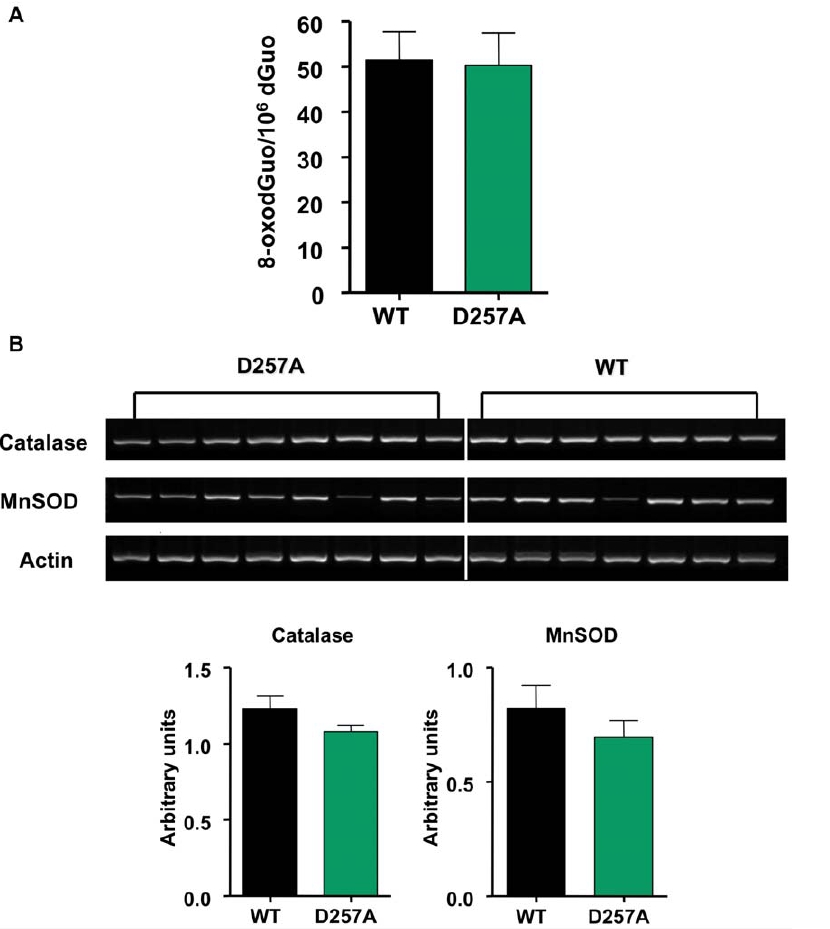
Figure 9. Mitochondrial DNA oxidation levels and antioxidant enzyme mRNA expression remain unaltered in D257A skeletal muscle. (A) We examined a marker of ROS-induced oxidative damage to DNA by assessing the levels of 8-oxodGuo in skeletal muscle mtDNA of 11- mo old WT and D257A mice (n=11 per group), using HPLC with electrochemical detection. No statistically significant differences were detected. Mean values 6 SEM are shown. (B) We measured Catalase and MnSOD mRNA expression in skeletal muscle extracts from 11-mo old WT (n=7) and D257A (n=8) mice by RT-PCR. Arbitrary units represent specific mRNA densitometry values normalized to actin mRNA densitometry values. No statistically significant differences were detected. Mean values 6 SEM are shown.